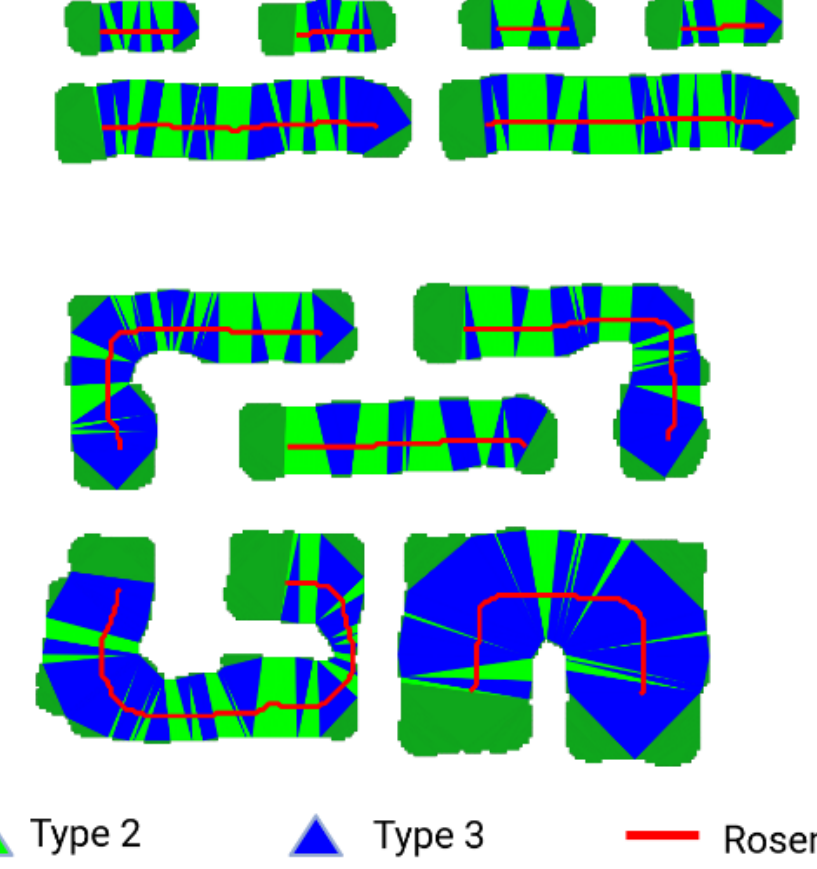
Figure 6. Extraction of the triangle in which the skeleton line was